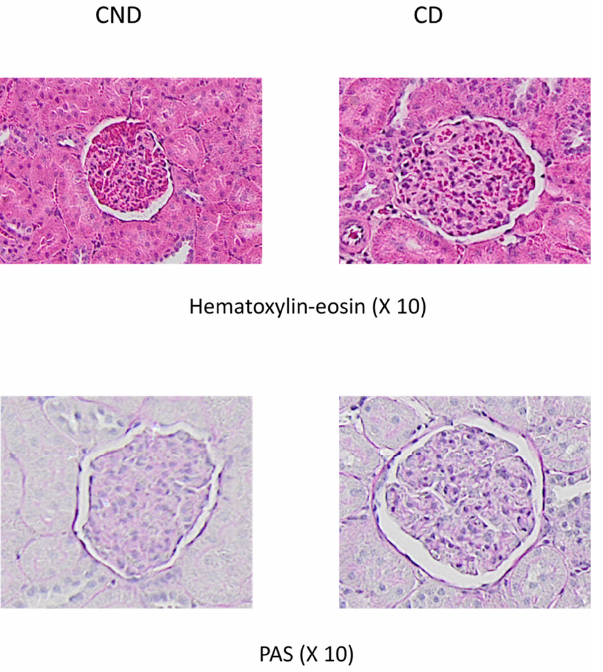
Figure 2. Representative examples of glomerular images from control non-diabetic rats (NDR) and control diabetic rats (DR). Top panels: hematoxylin ‐ eosin staining. Bottom panels: PAS staining. The oxidative stress parameters determined both in serum and in renal tissue were altered in diabetic animals, mainly an increase in those with defined oxidative damage (increases in TBARS, oxLDL, and 8 ‐ OHdG) and a decrease in antioxidant defense (GSH and TAC) (Table 3). Likewise, the nitrosative stress parameter (3 ‐ nitrotyrosine) increased significantly in control diabetic animals (Table 3). DHPG decreased the values of oxidative and nitrosative damage and slowed down the fall in antioxidant defense. Table 3. Serum and kidney variables (mean ± standard error of the mean) of the oxidative and ni ‐ trosative stresses of non ‐ diabetic rats (NDR). Diabetic control rats (DR) and DR were treated with 3 ′ ,4 ′‐ dihidroxifenilglicol (DHPG) 0.5 or 1 mg/kg/day p.o. (DHPG ‐ 0.5. DHPG ‐ 1). N = 10 rats per group. Variable NDR